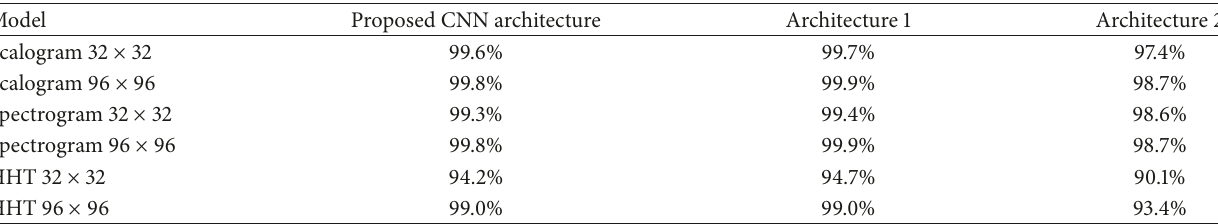
Table 24: Specificity for CWR data set.